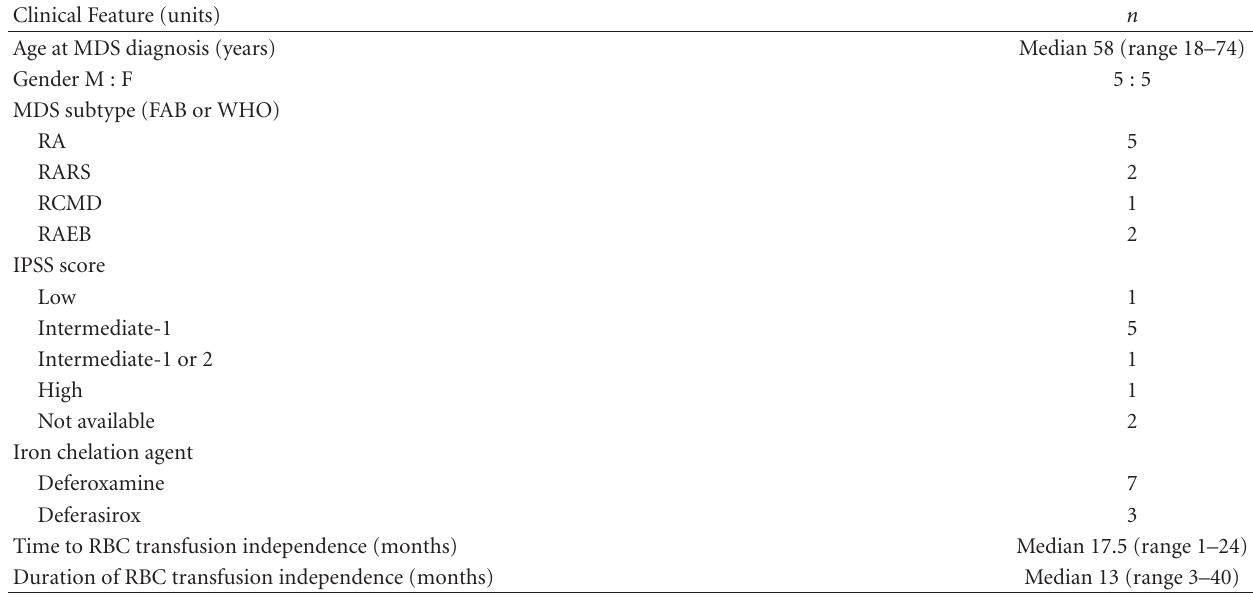
Table 1: Clinical characteristics of 10 MDS patients achieving red blood cell transfusion independence with iron chelation therapy. Clinical Feature